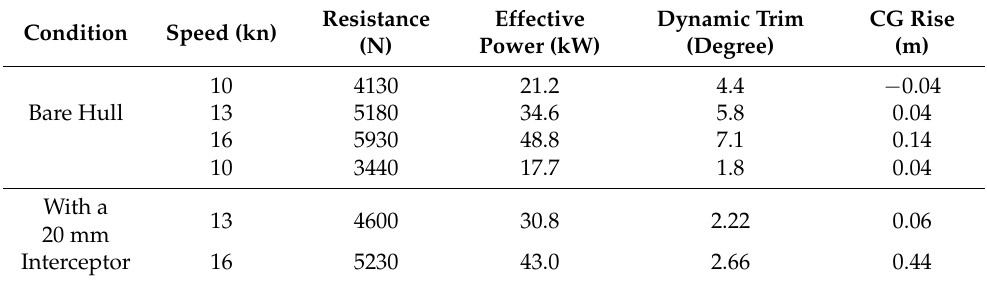
Table 5. Hydrodynamic properties of the bare hull and of the hull with the interceptor at displacement = 3650